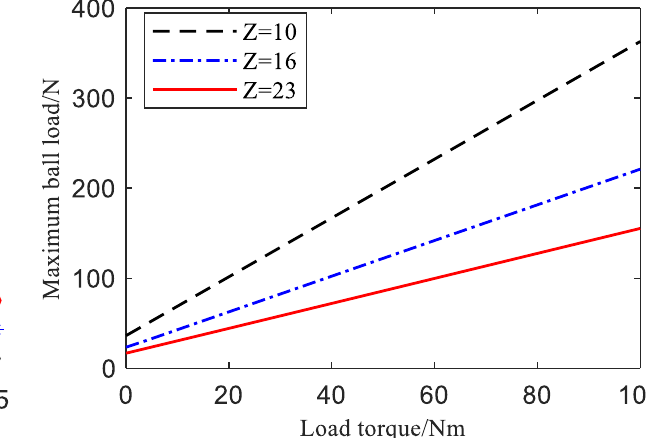
Fig. 9. Relationship of maximum ball load and load torque under different number of balls.